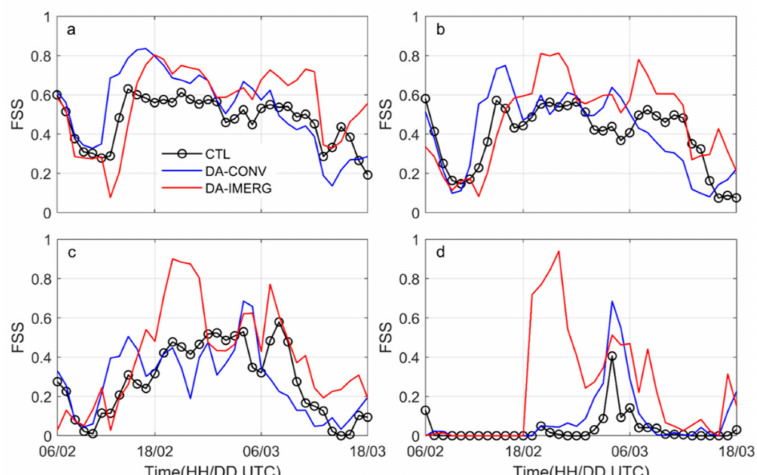
Figure 11. Fractions skill scores for the hourly precipitation threshold of ( a ) 1.0 mm / h, ( b ) 2.5 mm / h, ( c ) 5.0 mm / h, and ( d ) 10 mm / h at grid scale in the domain D2 for the TC Jondari. The precipitation observation used in the score is from the IMERG-L.